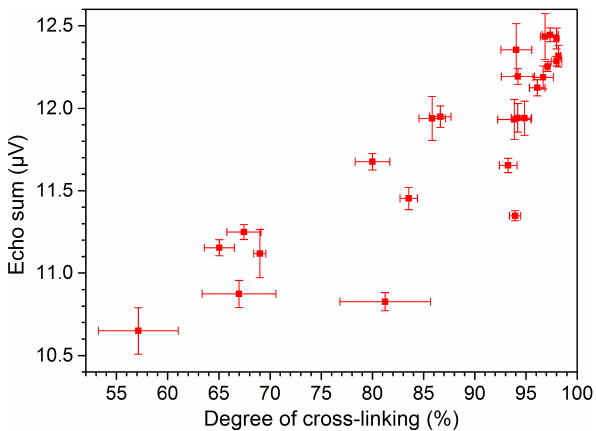
Figure 8. Echo sums from different measurement positions of PE- Xa samples.